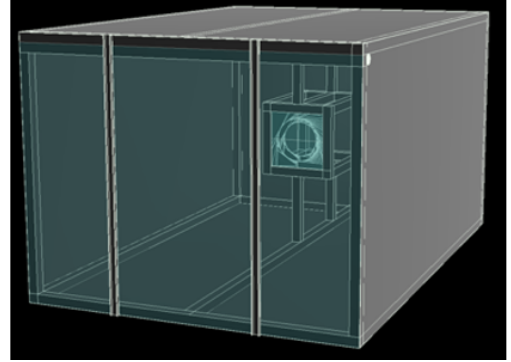
Figure 10. Reproduced CRAFFT detector configuration in the ray tracing simulation.